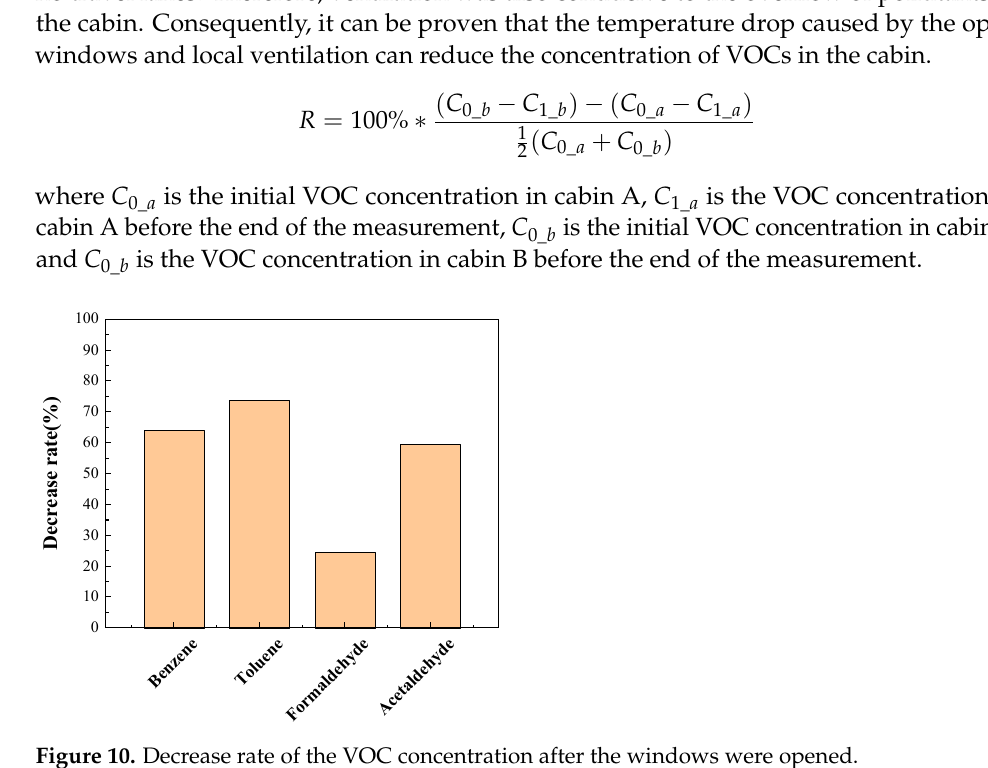
Figure 10. Decrease rate of the VOC concentration after the windows were opened.